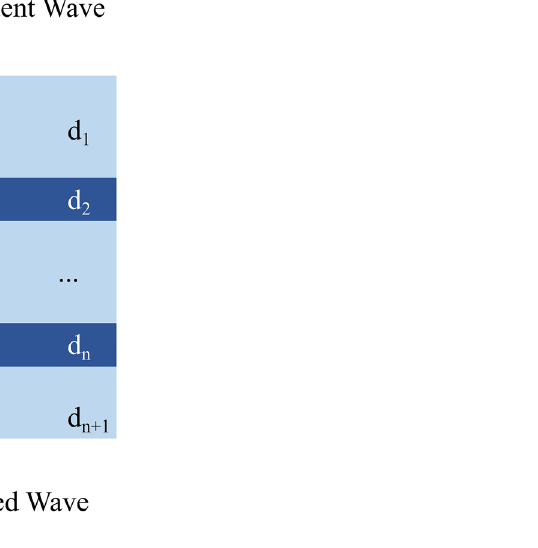
Figure 15. Double-layer shield model 28